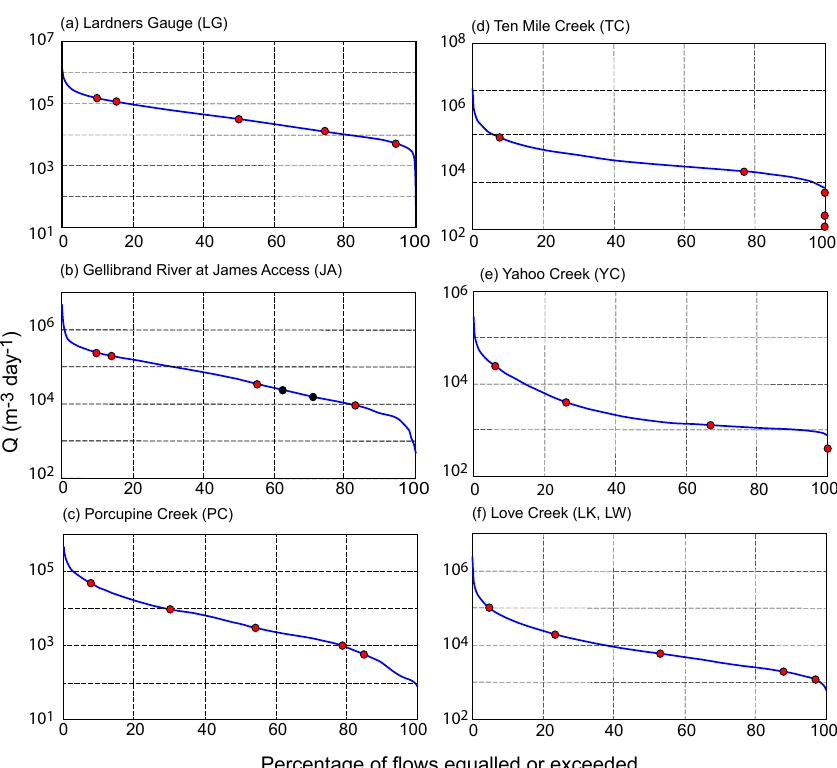
Figure 2. Streamflows at which samples were collected relative to flow duration curves for Lardners Gauge (a) , Gellibrand River at James Access (b) – additional data (black circles) from Atkinson (2014), Porcupine Creek (c) , Ten Mile Creek (d) , Yahoo Creek (e) and Love Creek (f) . Streamflow data from Department of Environment, Land, Water and Planning